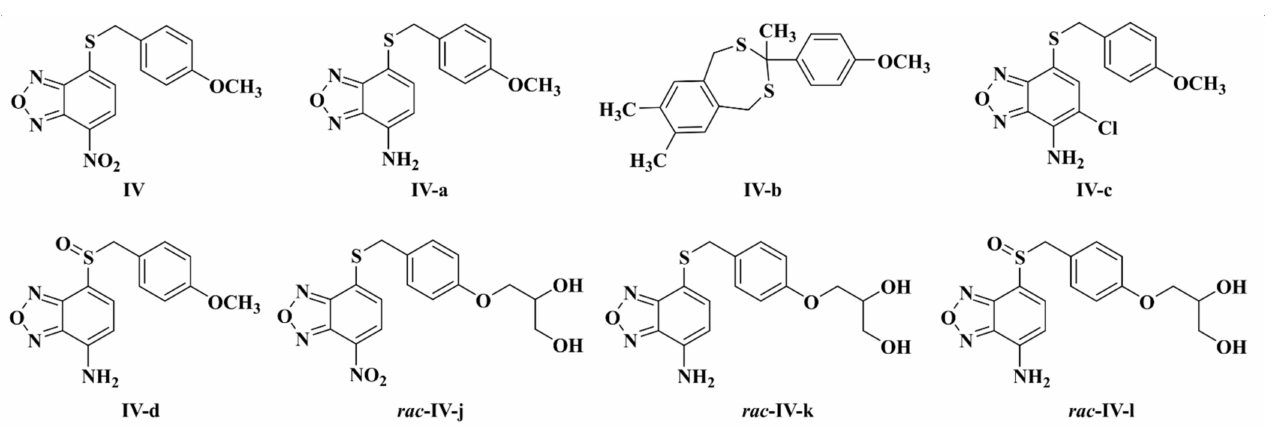
Figure 1. Compounds tested for antimicrobial activity against